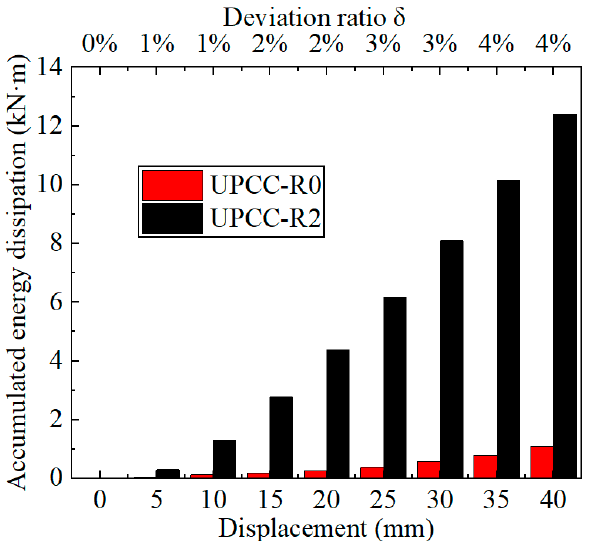
Figure 14. Cumulative energy dissipation curves of two types of piers.